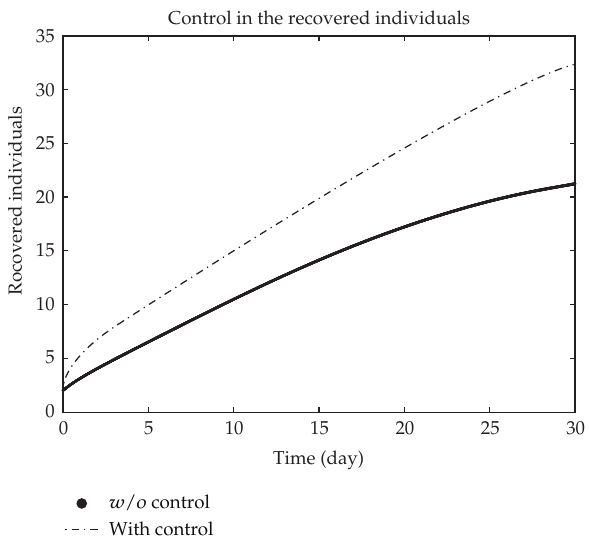
Figure 6: The plot represents the population of recovered class with and without